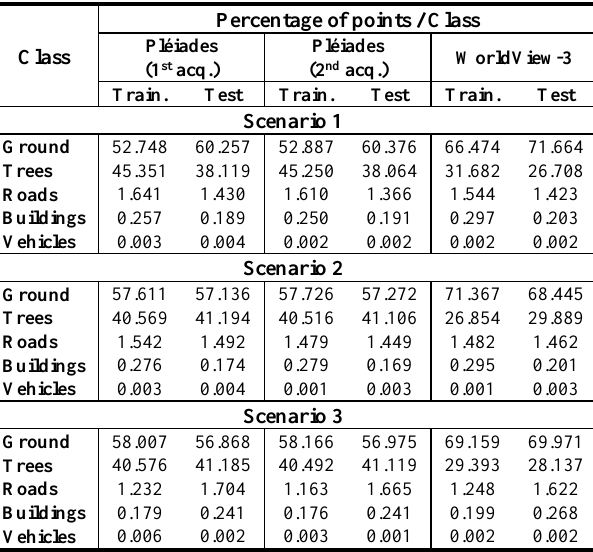
Figure 3. Overview of the different scenarios with the selections for the training and test data